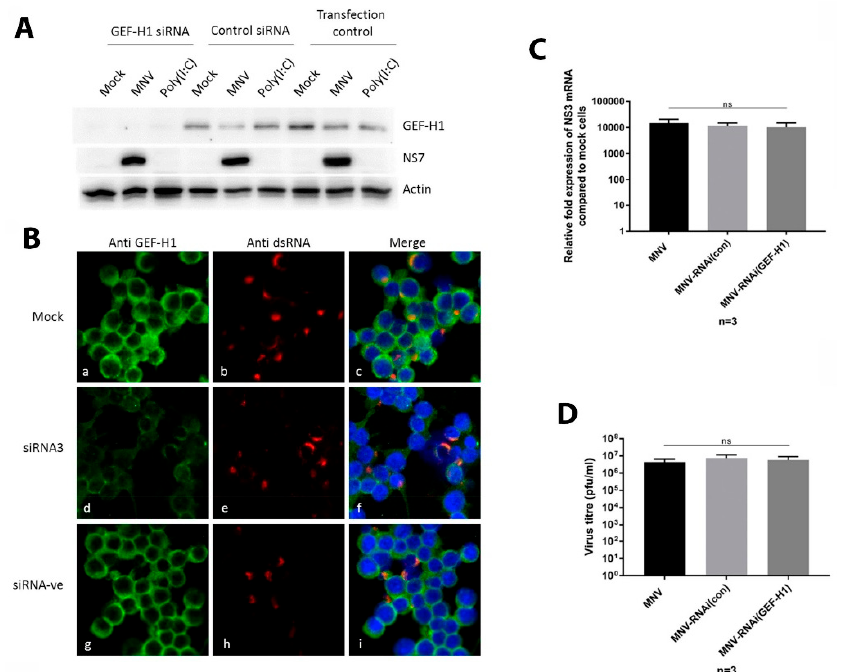
Figure 5. Suppression of the GEF-H1 expression does not influence MNV replication or the protein production of the infectious virus release. RAW264.7 cells were treated twice with GEF-H1 siRNA (siRNA3) or control siRNA (siRNA-ve), before cells were infected with MNV (MOI 5) for 12 h. ( A ) The immunoblot analysis of whole cell lysates stained with antibodies against GEF-H1, NS7, and actin. ( B ) Panels a, d, and g show the staining for the anti-GEF-H1 antibody; panels b, e, and h display the staining with an anti-dsRNA antibody; and panels c, f, and i represent the merged pictured of all the channels including the nuclear stain (DAPI). Stained cells were analysed via confocal microscopy. ( C ) Cells were lysed, and RNA was extracted. The relative fold expression of MNV mRNA compared to mock cells was analysed via RT-qPCR. ( D ) The supernatant of the infected cells was collected and used to determine viral titres via plaque assay. ( n = 3, average ± SEM, not significant [ns]: p > 0.05; one-way